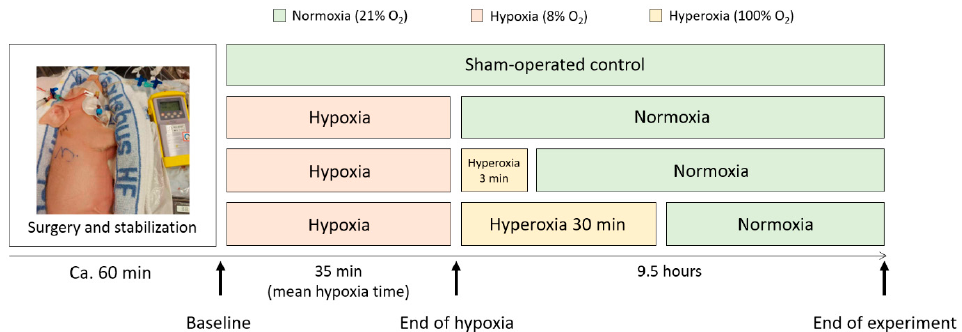
Figure 1. A schematic overview of the four study arms in the perinatal asphyxia piglet model. The piglets underwent anesthesia and surgery and were stabilized for 1 h before inducing hypoxia. The hypoxic mean time was 35 min, and the piglets were observed for 9.5 h after the end of hypoxia. The control group only received air (21% O 2 ), while all treatment groups first received 8% O 2 (hypoxia), followed by either 21% O 2 (Reox-21%), 3 min of 100% O 2 (Reox-100% (3 ′ )) or 30 min of 100% O 2 (Reox-100% (30 ′ )). Hypoxia was induced by ventilation with 8% O 2 in N 2 until the base excess (BE) reached − 20 mM/L, or the mean arterial blood pressure (MABP) decreased to 20 mmHg before the piglets were reoxygenated (Supplementary Table S1). The Reox-21% group was purely reoxygenated with 21% O 2 . The hyperoxic groups were reoxygenated with 100% O 2 for either 3 (Reox-100% (3 ′ )) or 30 (Reox-100% (30 ′ )) minutes, followed by 21% O 2 for the remaining time of the experiment. The control group received 21% O 2 throughout the entire experiment and was treated identically to the other groups but was not exposed to hypoxia or hyperoxia (Figure 1). Arterial blood gas measurements, heart rate, oxygen saturation, blood pressure, and temperature were continuously monitored. In addition, the anesthesia and analgesia of the pigs were continuously assessed. All the piglets were observed for 9.5 h after the end of hypoxia and then euthanized with an overdose of pentobarbital (150 mg/kg) intravenously. The brain was immediately removed, and tissue specimens were collected from the right hemisphere of the brain, including the prefrontal cortex, the hippocampus, the white matter, and the cerebellum. All tissue samples were snap-frozen in liquid nitrogen and stored at − 80 °C until further analysis. Four piglets died before the completion of the experiment and were therefore excluded. An autopsy revealed organ abnormalities in three piglets from the control group, indicating that they were unsuitable as controls and were hence excluded (Supplementary Table S1).